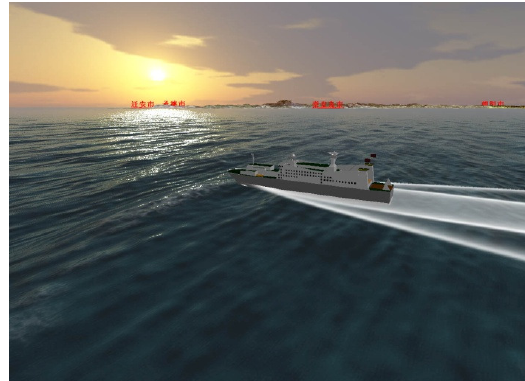
Figure 6a. moving object on the sea